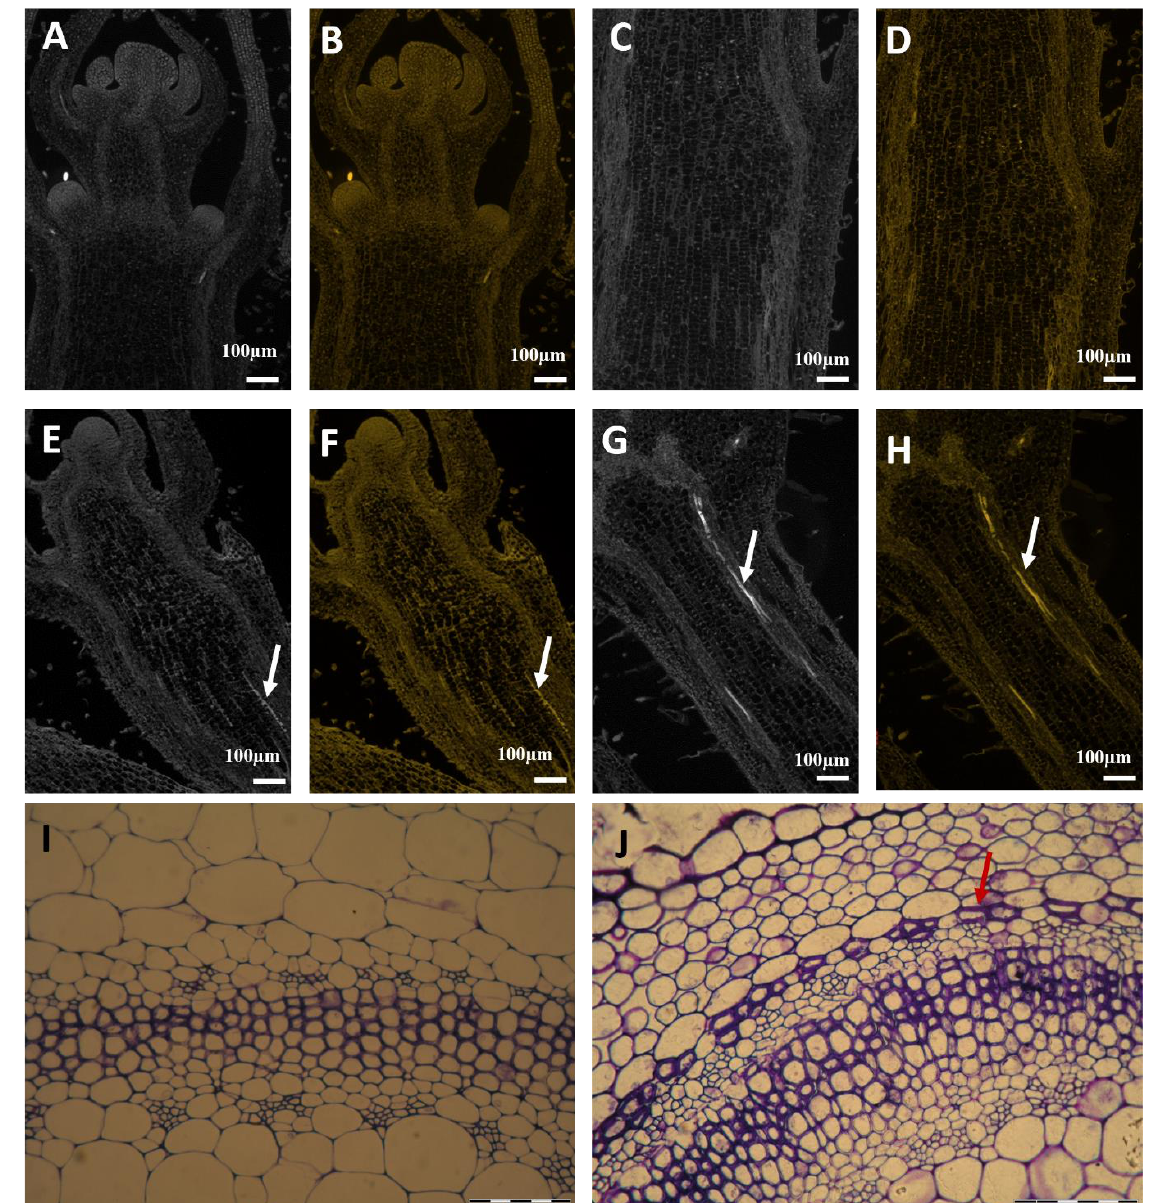
Figure 6. Histological determination of cell wall lignification in vascular bundles of stems of P. atkinsiana . ( A – D )—longitudinal section of the stem of control plants. Tracheary elements are not visible in vascular bundles. ( E – H )—longitudinal section of the stem of plants subjected to MS 160 times. Tracheary elements are clearly visible in vascular bundles. Arrow-tracheary elements. ( I , J )—cross-section of the stems of control ( I ) and subjected to MS 160 times ( J ). Usually, plants subjected to stress develop reinforcing tissue, such as collenchyma or sclerenchyma, resulting in the arrest of developing growth. ( I )—cross-section of the stem of control plants. Sclerenchyma cells are not visible. ( J )—cross-section of the stem of plants subjected to MS 160 times. Sclerenchyma cells are clearly visible. Arrow—sclerenchyma